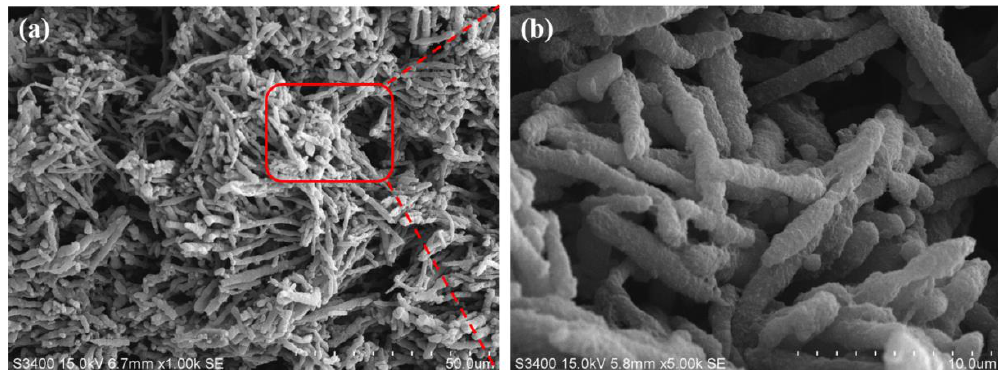
Figure 2. (a) SEM micrographs of the CB/PA6/PP MFCs after dissolving away PP, ( b ) SEM micrographs of red square region of Figure 2a at a higher magnification.